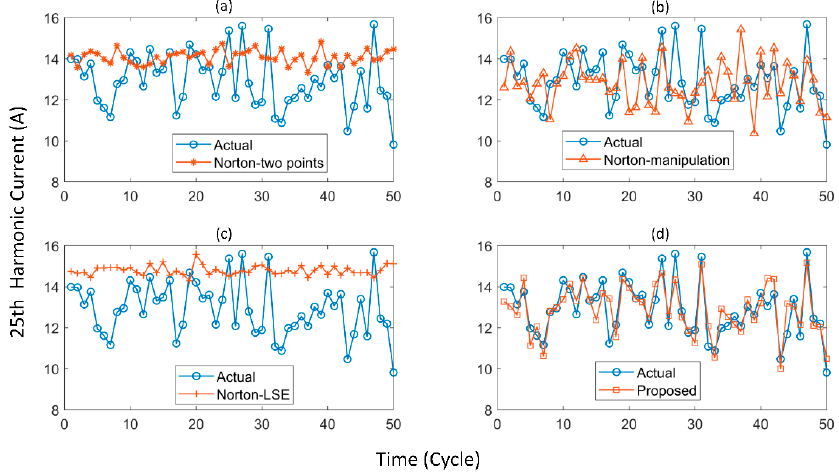
Figure 12. Comparisons of 25th harmonic current between actual measurement and estimations by Norton-two point method ( a ), Norton-manipulated method ( b ), Norton-LSE method ( c ) and the proposed method ( d ).